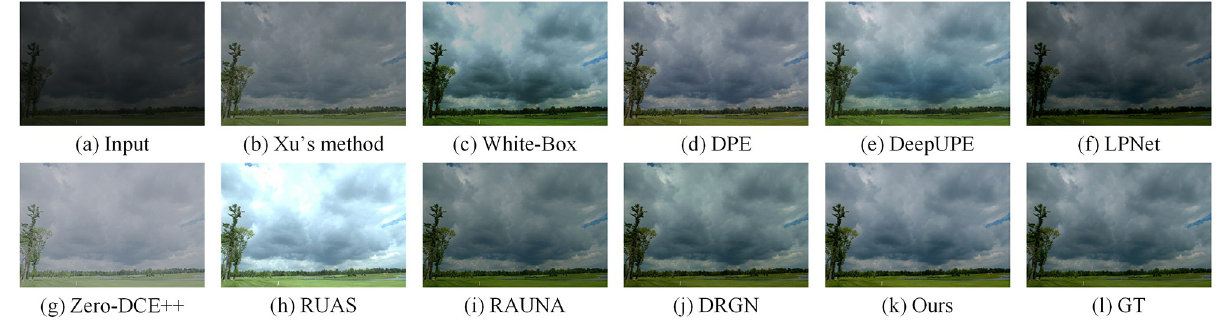
Fig 8. Visual results of different methods on MIT5K dataset for image number 4832. (a) Input. (b) Xu’s method. (c) White-Box. (d) DPE. (e) DeepUPE. (f) LPNet. (g) Zero-DCE++. (h) RUAS. (i) RAUNA. (j) DRGN. (k) Ours. (l) GT.